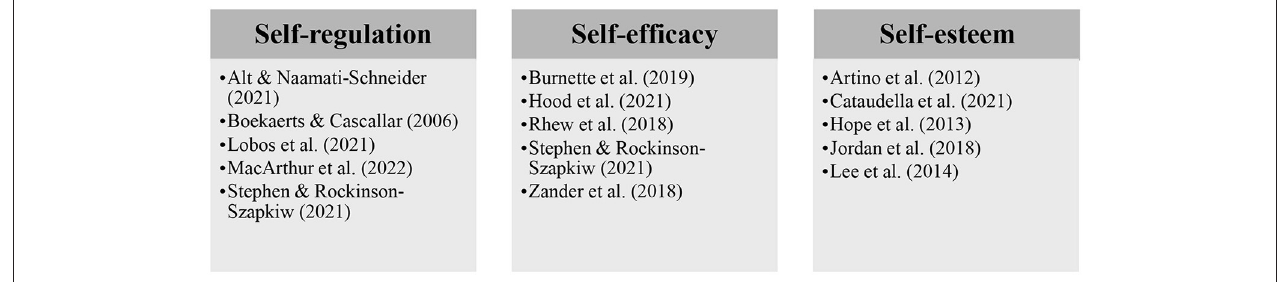
FIGURE 2 | A practical framework for practicing growth mindset-related components & related references.